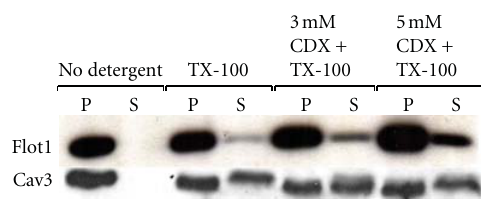
Figure 3: Flotillin 1 is more sparingly soluble in cold Triton X-100 than cav 3. Isolated myofibers were treated with 0, 3, and 5mM CDX and then extracted with 1% Triton X-100. Soluble material (S) and pellets (Ps) were subjected to SDS/PAGE and western blotting using specific antibodies. Treatment of the myofibers with CDX only slightly increased the solubility of flotillin 1 to the detergent, whereas the solubility of cav 3 remained una ff